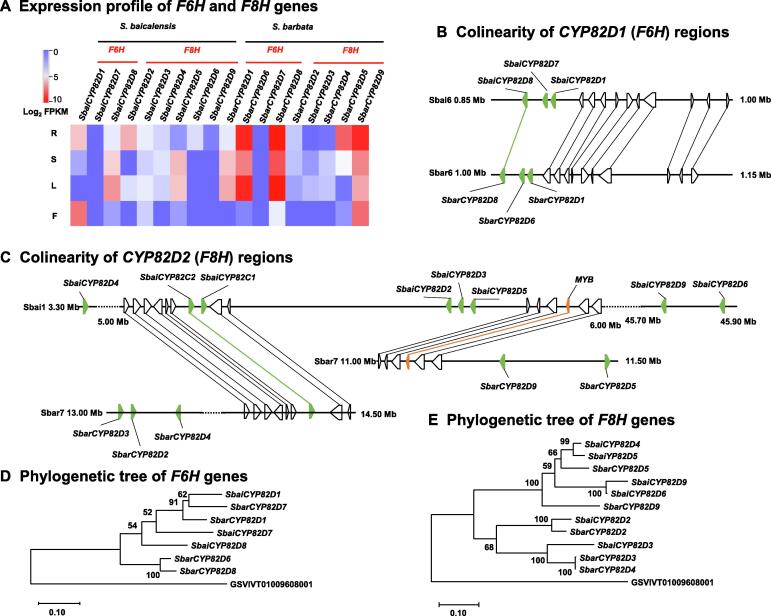
Tandem repeat of flavone hydroxylase genes revealed the divergent evolutionA. Identification and expression of CYP82D subfamily genes, including F6H and F8H. B. Colinearity of CYP82D1 (F6H) regions between S. baicalensis and S. barbata. C. Colinearity of CYP82D2 (F8H) regions between S. baicalensis and S. barbata. The green triangles represent CYP450 genes. The orange triangle represents MYB transcription factor gene. The black triangles indicate neighboring genes of the selected CYP450 genes. D. Phylogenetic tree of F6H genes. E. Phylogenetic tree of F8H genes. Grape CYP82D (GSVIVT01009608001, http://plants.ensembl.org/Vitis_vinifera) was chosen as the outgroup to generate both trees. MYB, my elob lastosis.